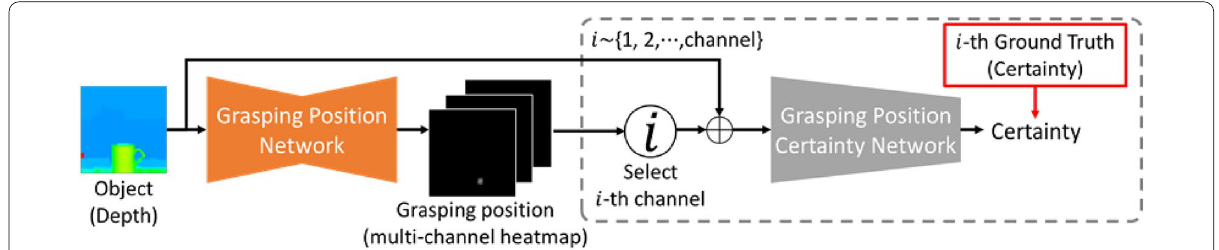
Fig. 5 Learning flow of the grasping position certainty